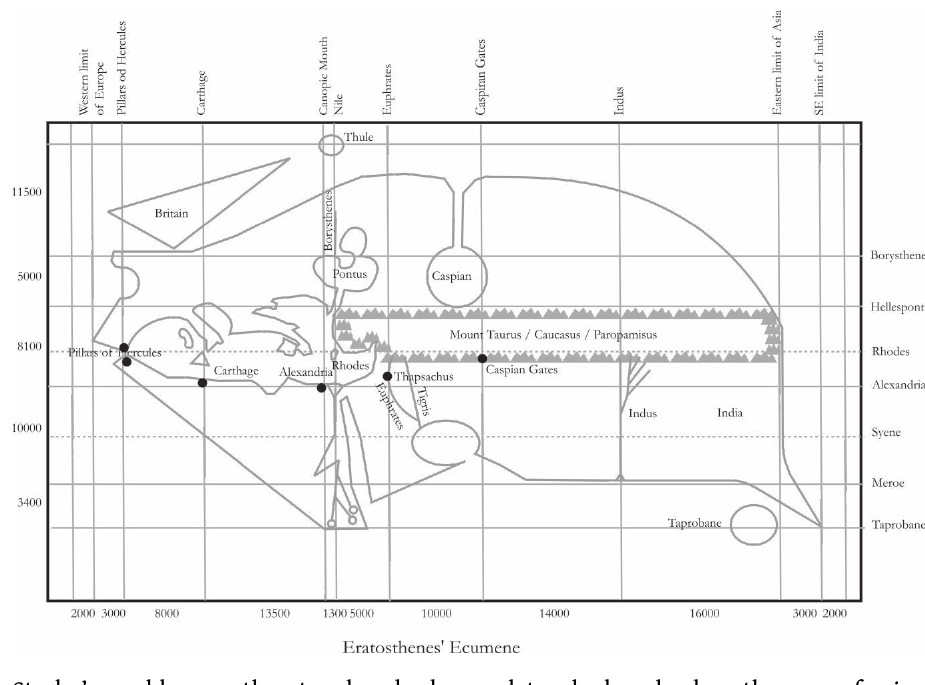
Figure 7. Eratosthenes’ world